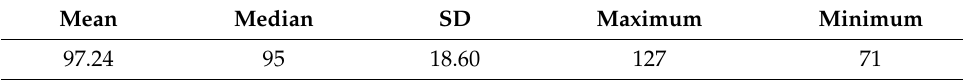
Table 2. Descriptive data of the number of stand-to-stand cycles.